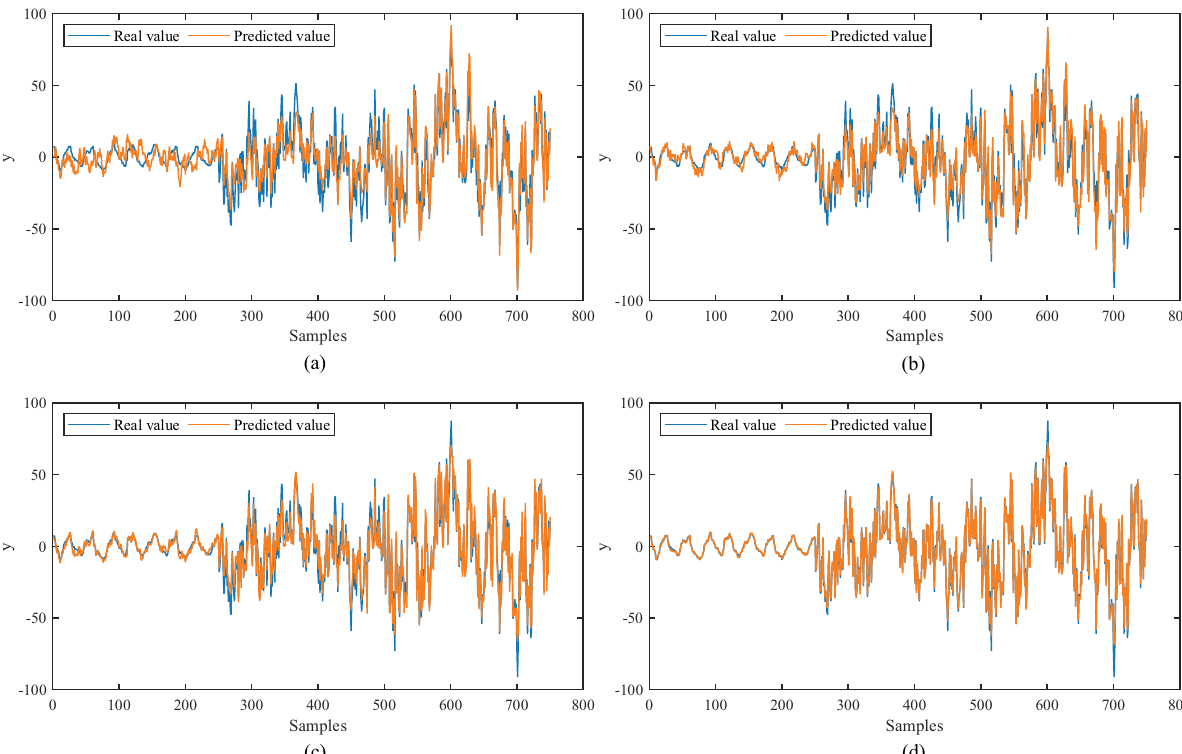
Figure 6: Prediction results of ( a ) PLS, ( b ) BPNN, ( c ) SAE, and ( d ) vMF - WSAE for the numerical simulation